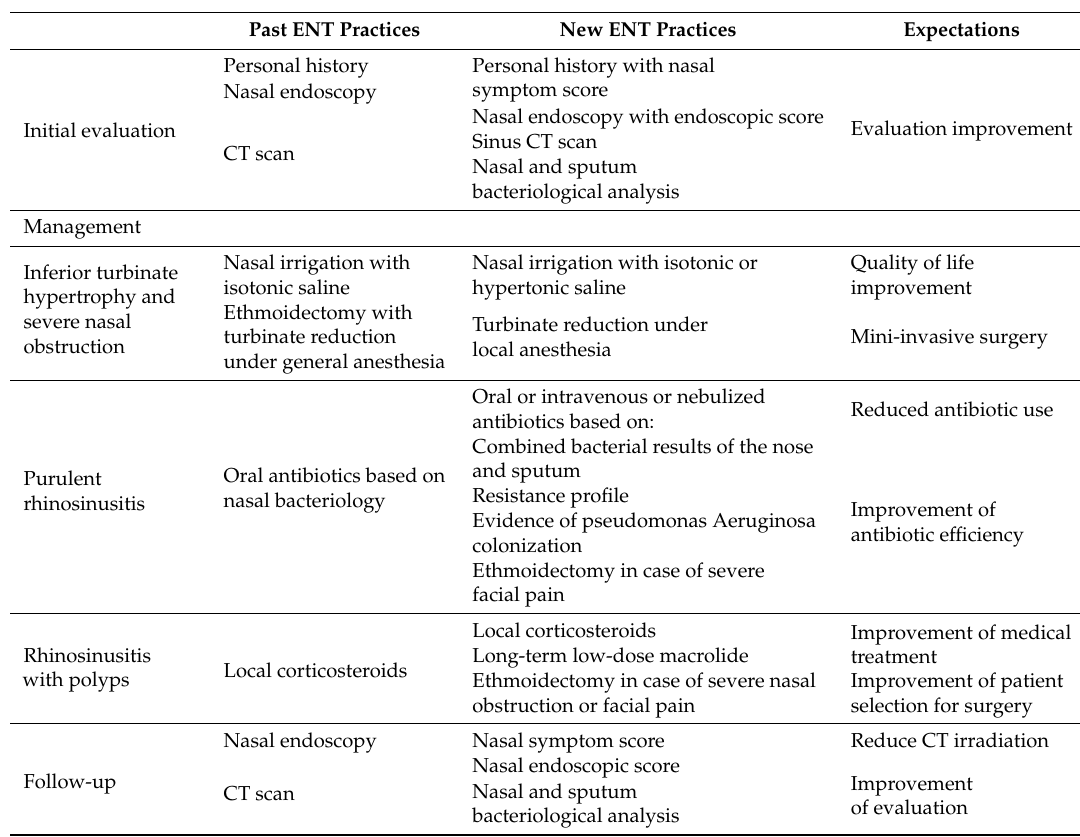
Table 5. Experience of our centers: newly implemented ENT clinical practices in adults with PCD and expectations of these